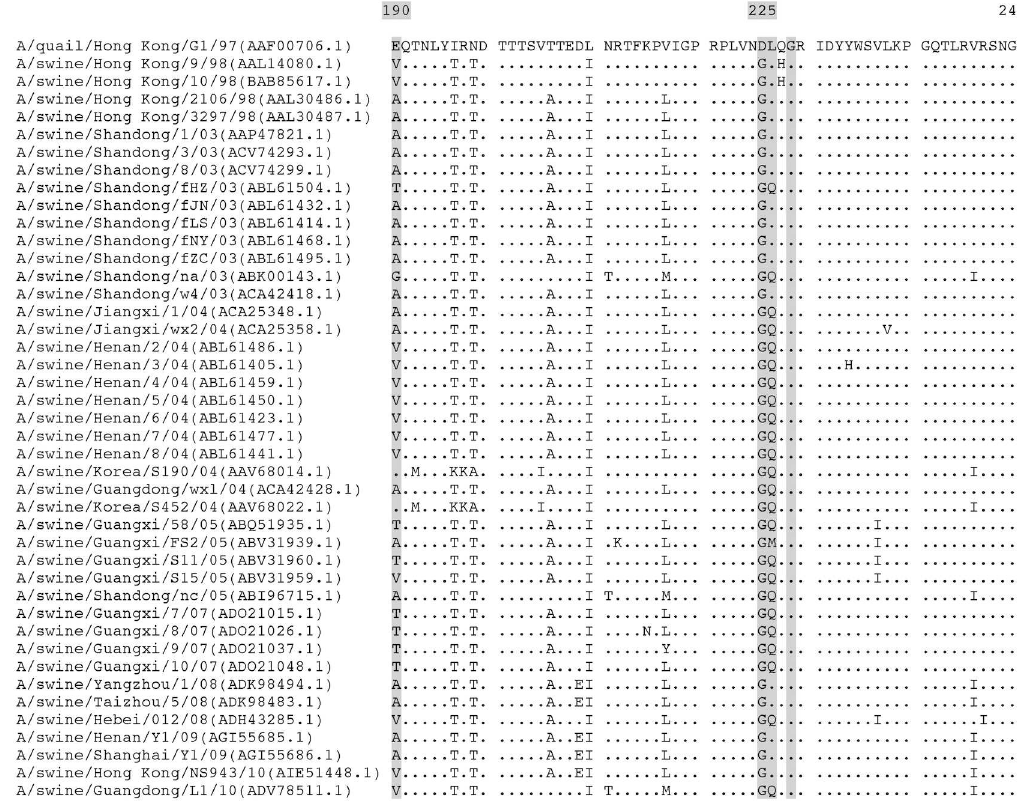
Fig 4. Alignment of the deduced amino acid sequences in the HA of all swine H9N2 isolates (n = 47) available in Genbank on 22 nd August 2016. The name of each strain includedin the analysisis followedby the accession number betweenbrackets. Residuesat positions190, 225, 226 and 228 are highlighted in gray. Amino acids that are different from those in A/quail/Hong Kong/G1/1997 are shown, conservedresidues are shown as dots.